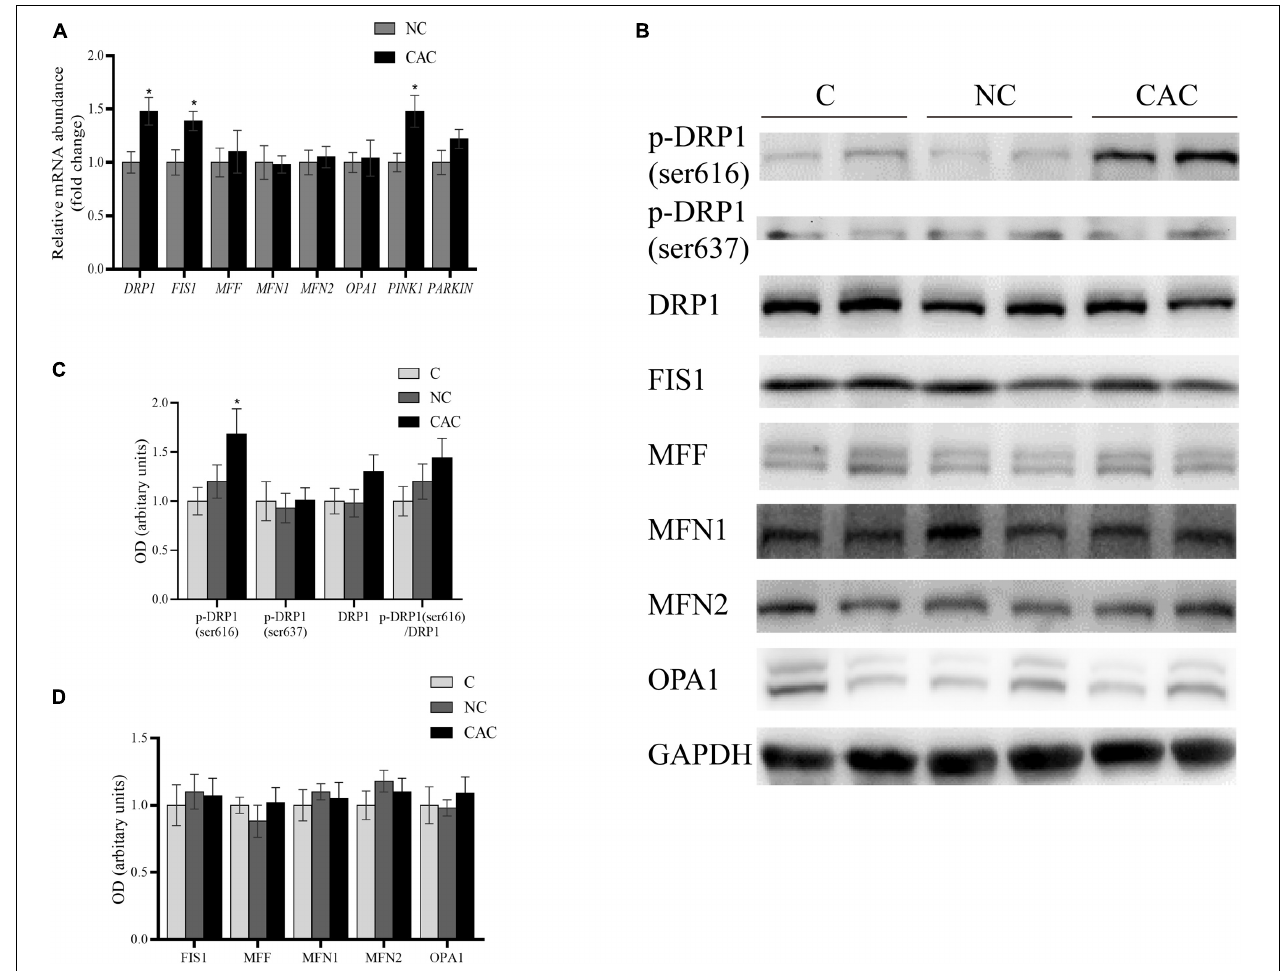
FIGURE 3 | (A) Quantification of relative gene expressions of DRP1, FIS1, MFF, MFN1, MFN2, OPA1, PINK1, and PARKIN by real-time PCR. (B) Levels of DRP1, p-DRP1(ser616), p-DRP1(ser637), FIS1, MFF, MFN1, MFN2, OPA1, and GAPDH by Western blot. (C) Quantification of DRP1, p-DRP1(ser616), p-DRP1(ser637), and DRP1/p-DRP1 ratio. (D) Quantification of FIS1, MFF, MFN1, MFN2, and OPA1. C, control, patients with benign disease; NC, patients of non-cachexia; CAC, cancer patients with cachexia. * p < 0.05. Data are displayed as mean ± standard